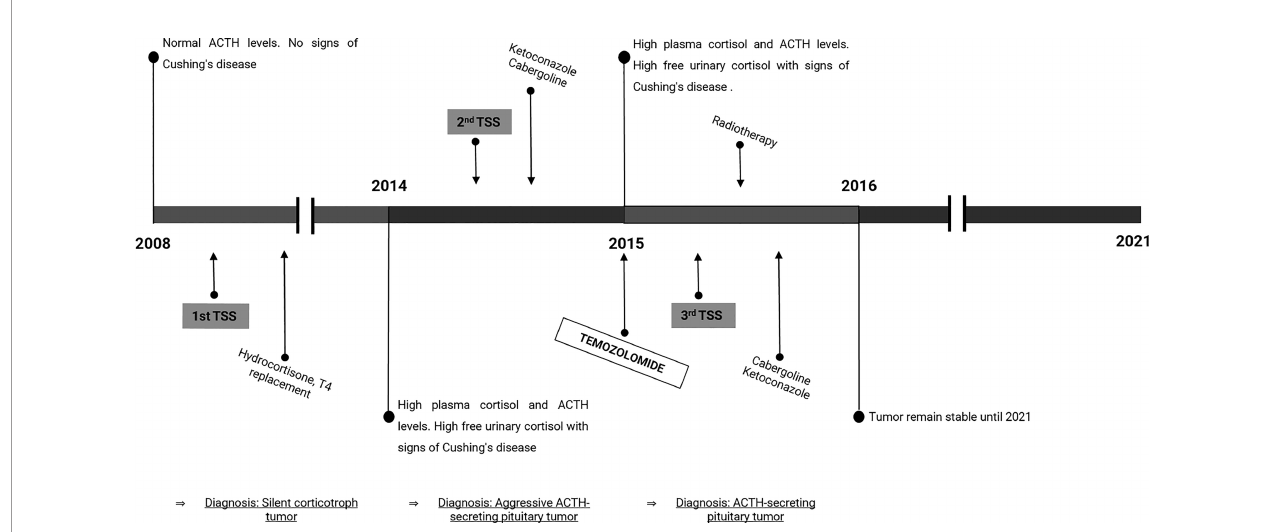
FIGURE 1 | Timeline of disease progression and treatment. The scheme represents the course of the disease along time, including the diagnosis, hormone levels, and treatments. TSS, Transsphenoidal surgery; T4,